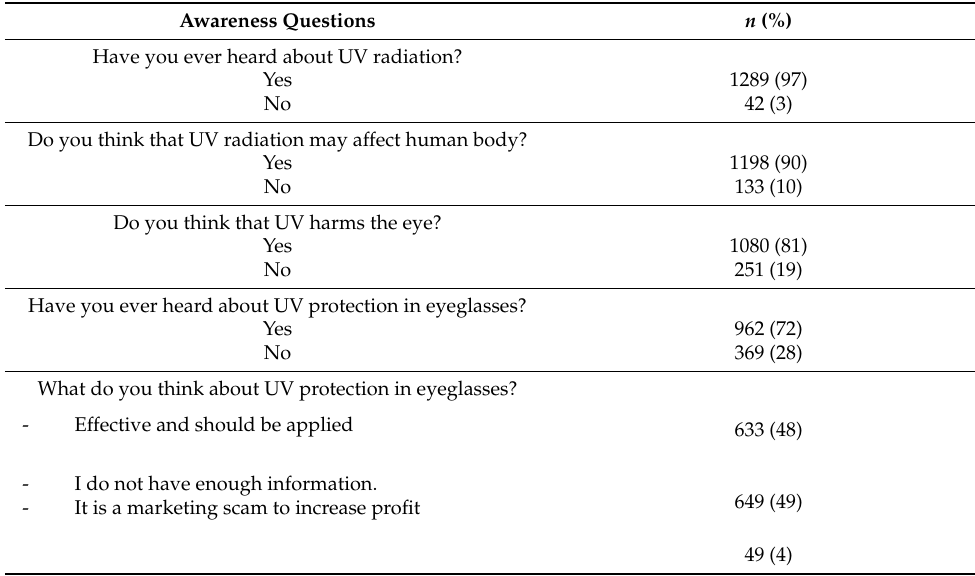
Table 2. Participant awareness to UV radiation and